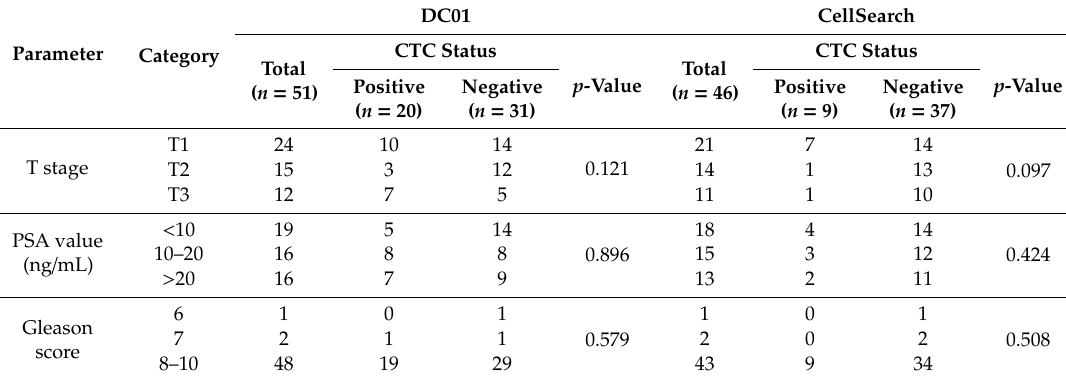
Table 1. Summary of clinical characteristics of high-risk PCa patients stratified by circulating tumor cell (CTC) status at first sampling time points based on the two CTC detection